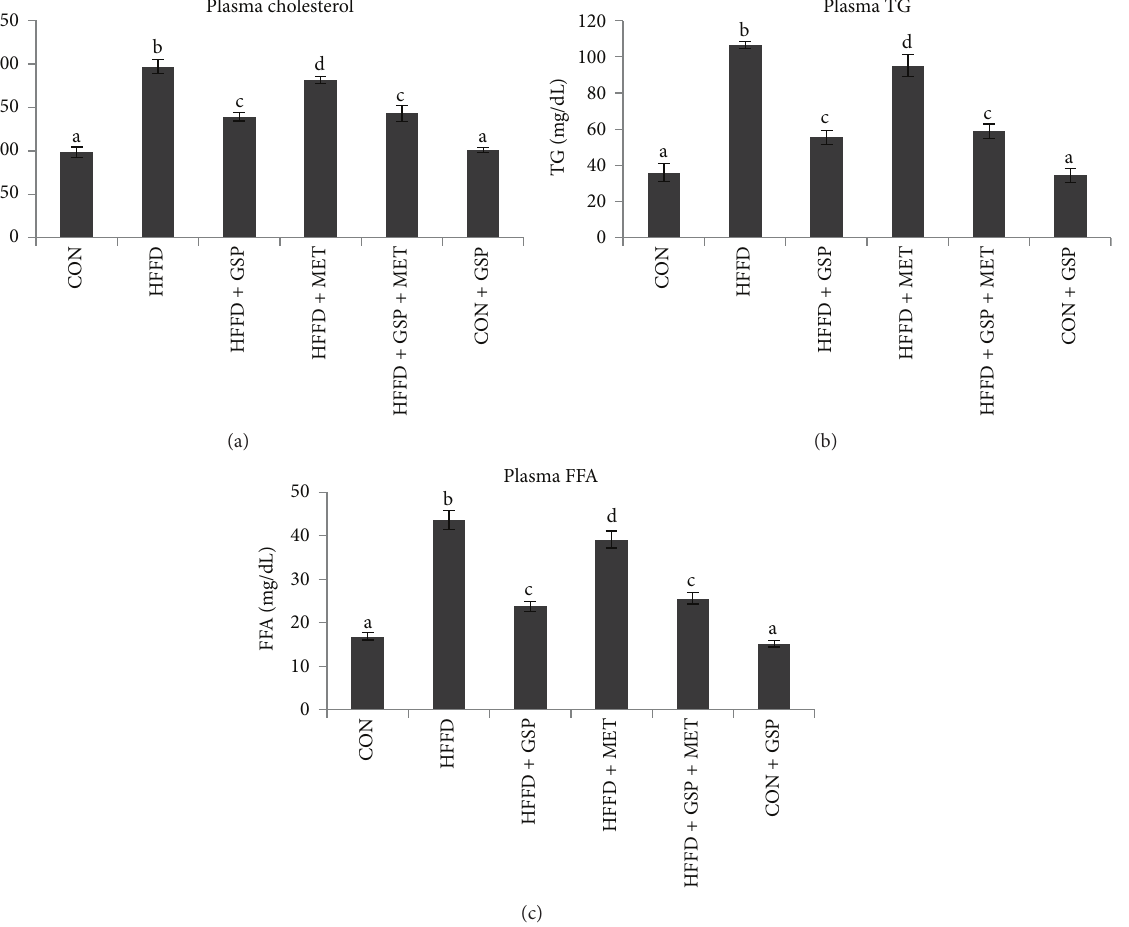
Figure 2: Effect of GSP and MET on levels of cholesterol (a), TG (b), and FFA (c) in plasma of experimental animals. Data are expressed as means ± S.D. of 6 rats from each group. Statistical significance between the groups, denoted by different alphabets, was determined by one-way ANOVA of significance set at 𝑃 < 0.05